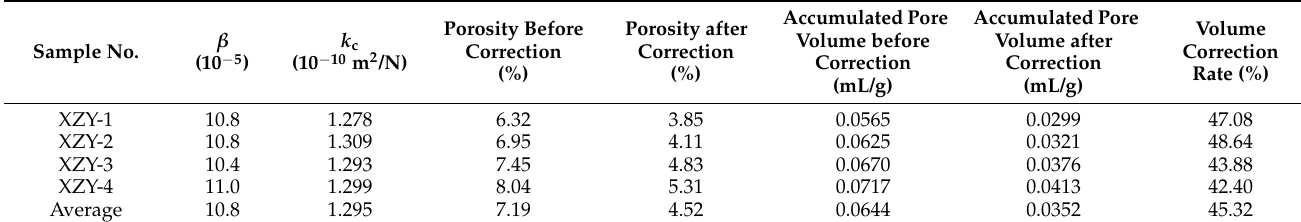
Table 3. Pore structure parameters before and after compressibility correction.